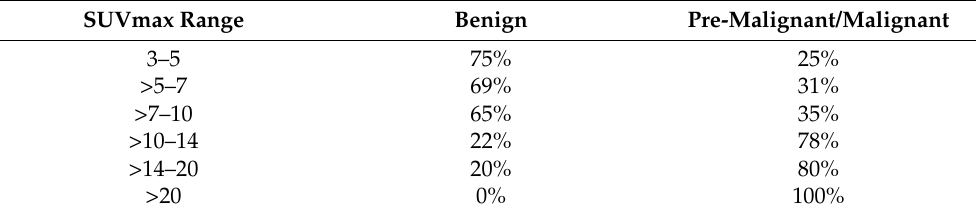
Table 7. Percentage of benign and pre-malignant/malignant lesions in each SUVmax group.